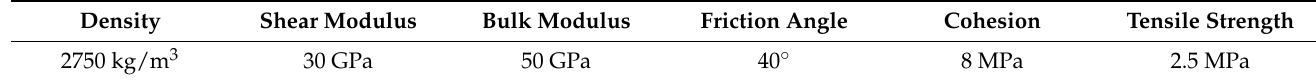
Table 2. Rock properties associated with Mohr-Coulomb failure criterion [49].